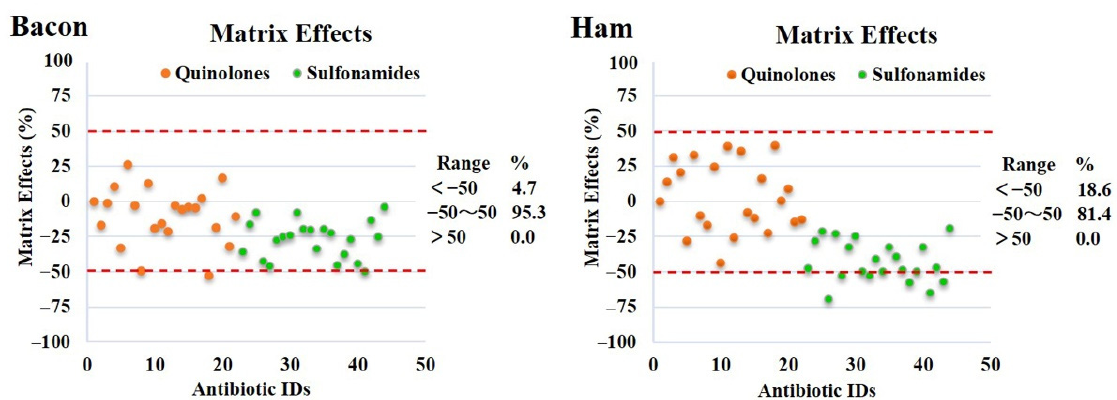
Figure 4. Matrix effect distribution of antimicrobial drugs in bacon and ham.